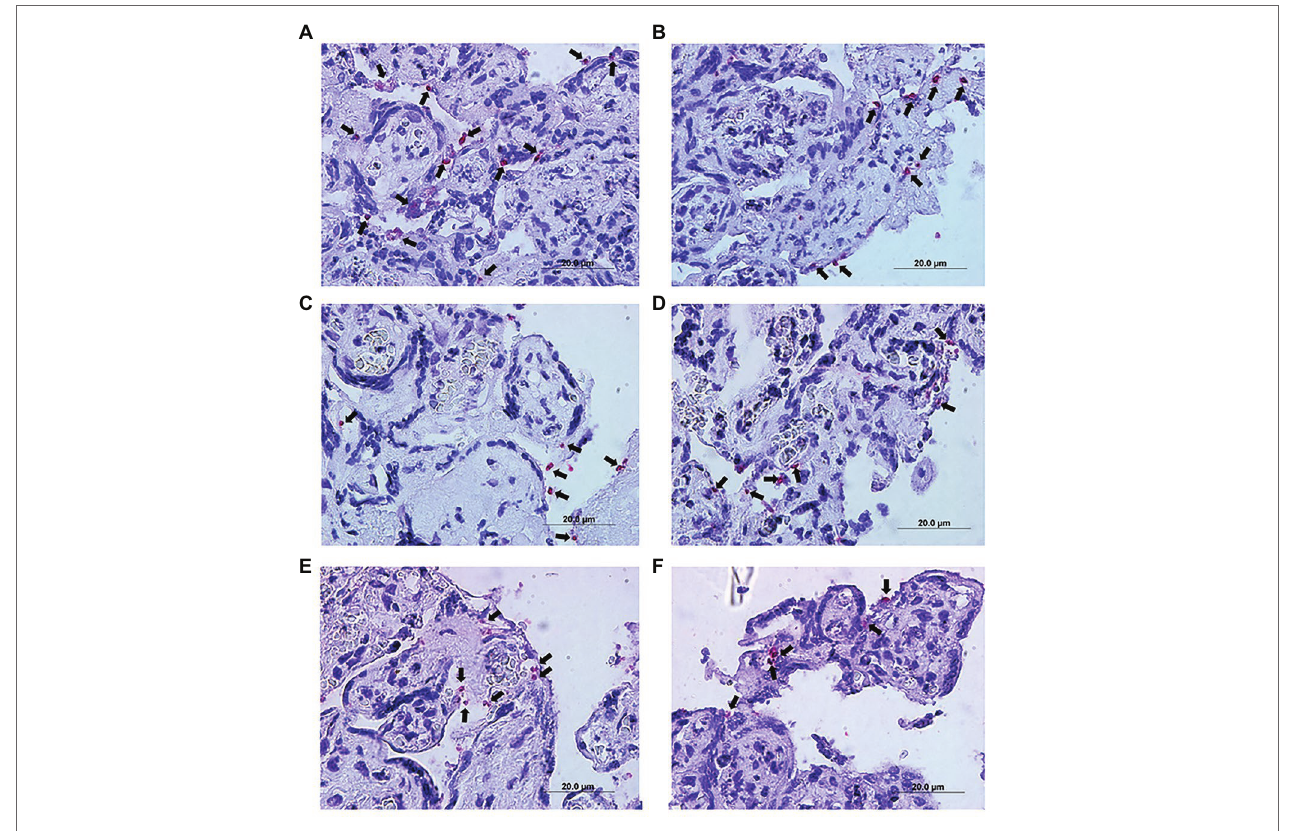
FIGURE 6 | Representative photomicrograph of infected villous explants and treated with different AgNp-Bio concentration or SDZ + PYR. (A) Control; (B) 25 μ M/ ml; (C) 50 μ M/ml; (D) 200 μ M/ml; (E) 800 μ M/ml; and (F) SDZ + PYR. The arrows indicate T. gondii tachyzoites immunolocated by immunophosphatase staining and counterstained with